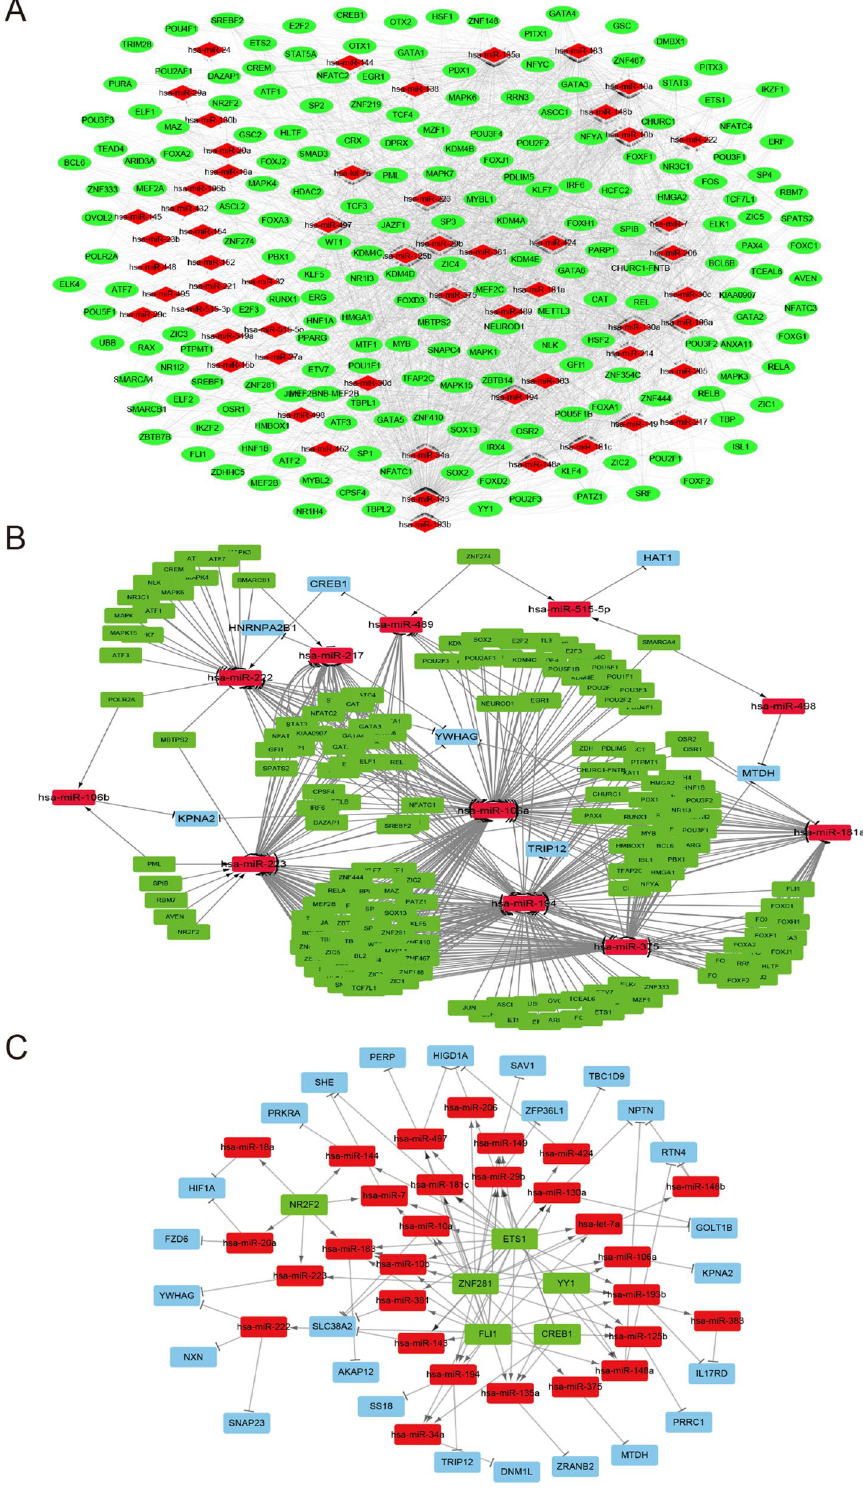
Figure 7. Transcription factor (TF) regulatory network. ( A ) TF-miRNA regulatory network. the red and green nodes indicate miRNAs and TFs, respectively. ( B ) TF-miRNA-target DEGs regulatory network. Blue nodes represent DEGs with a degree > 10 in the PPI network. ( C ) DETFs-miRNA-target regulatory network. Blue nodes represent DEGs, and the red and green nodes indicate miRNAs and DETFs respectively. The arrow indicates the TF-miRNA target relationship and the T shape represents the miRNA-target DEG relationship. TF, Transcription factor, DEGs, Differentially expressed genes, PPI, Protein–protein interaction, DETFs, Differentially expressed Transcription Factors. Created with cytoscape software 3.6.1 (www. cytos cape.